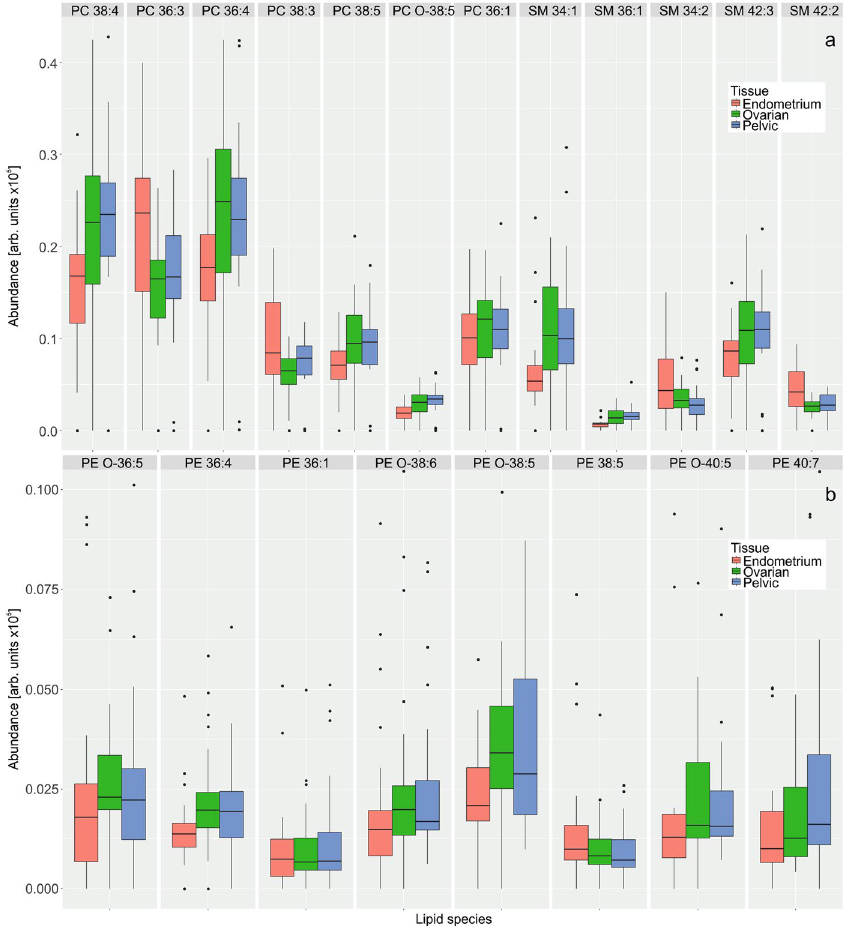
Figure 6. Comparison of relative abundances of lipid species with the highest VIP scores in normal and endometriotic tissues of thirty endometriosis patients determined using direct tissue analysis in ( a ) positive ion mode; ( b ) negative ion mode, only phosphatidylethanolamines are shown as they provide additional information in negative ion